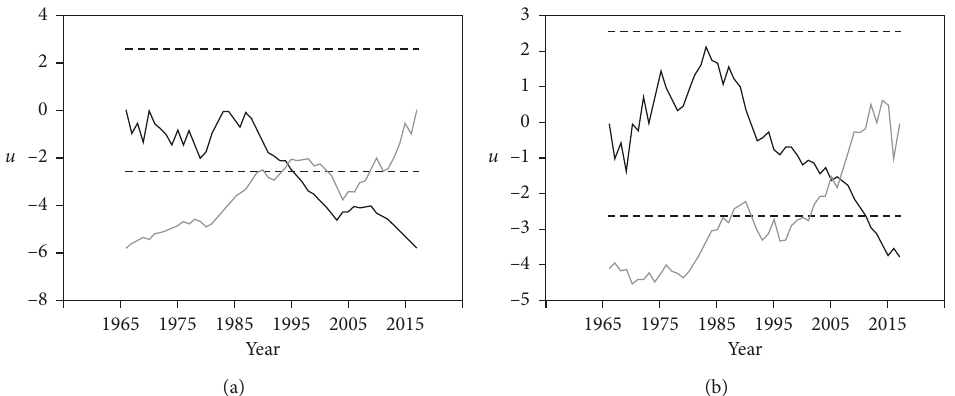
Figure 6: M-K analyses of ET 0 (a) and AI (b) over Northeast China. Solid line, C 1 ; gray line, C 2 ; dashed line, significance level at 0.05; the cross point of C 1 and C 2 was the start point in this